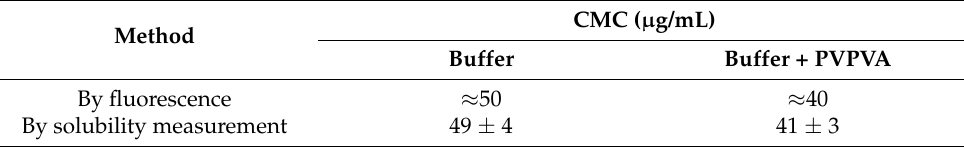
Table 1. Critical micelle concentration (CMC) of TPGS in pH 6.8 phosphate buffer with and without PVPVA.